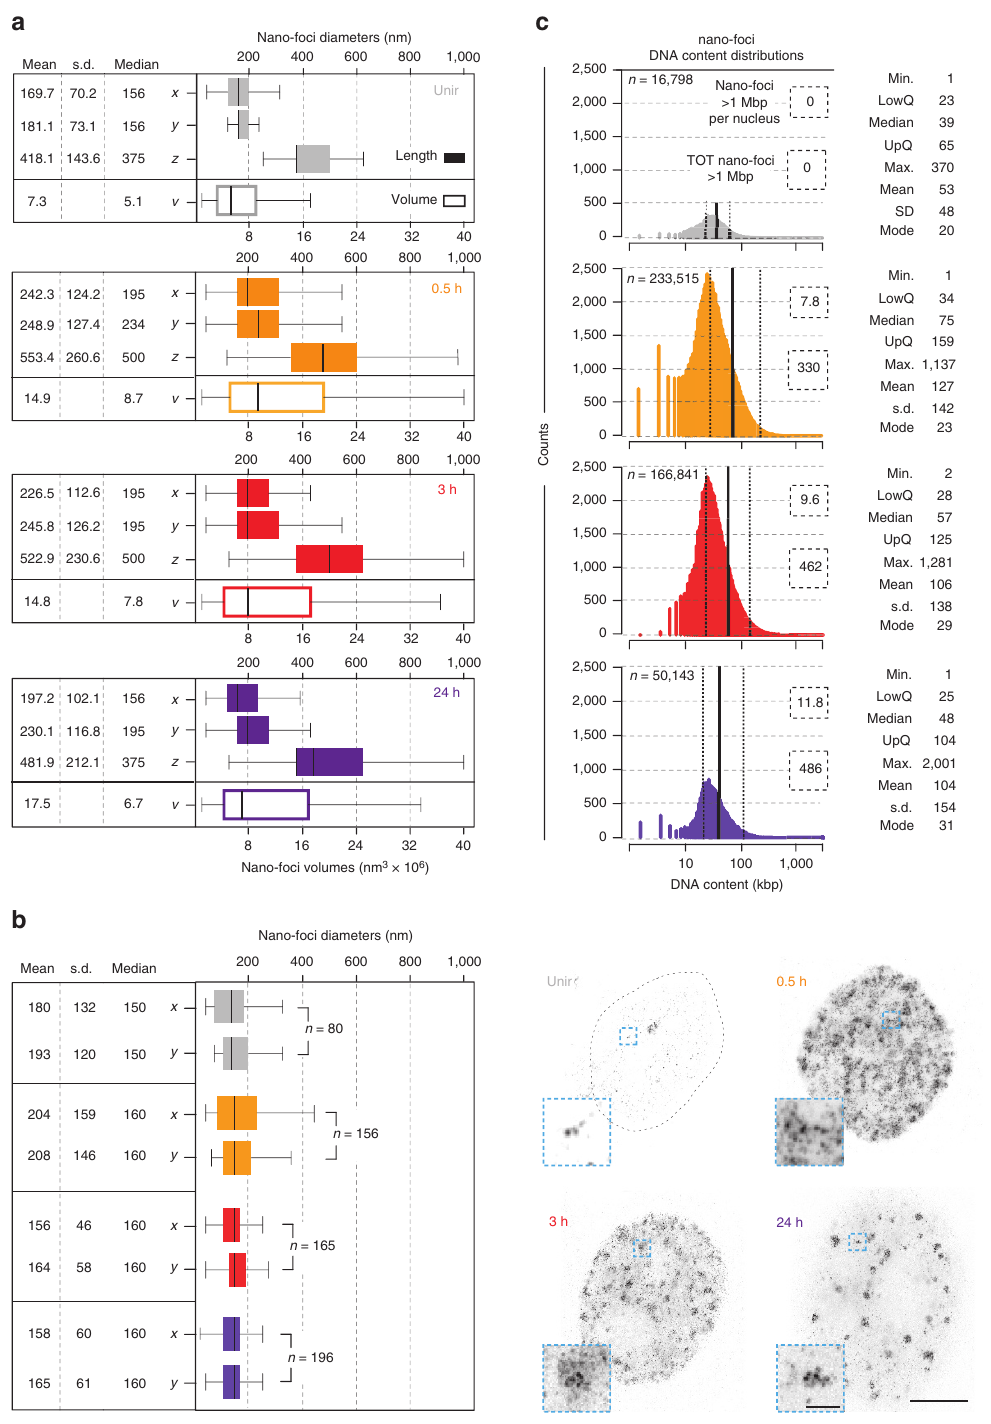
Figure 2 | Metrics of c H2AX nano-foci dimensions and DNA content. ( a ) Quantification of nano-foci diameters in the three dimensions (filled boxes, top) during DDR. From these three dimensions, the volumes were calculated (empty boxes, bottom). The difference between lateral and axial measurements is due to the lower resolution in the axial direction. Figures in nm or nm 3 (cid:3) 10 6 are shown. ( b ) STED microscopy of g H2AX immunofluorescence. (left) Quantification of lateral diameters of g H2AX nano-foci. Statistics and size scale are as in a . (right) Exemplary STED images of cells before and after IR are shown together with the magnified views of the light-blue boxes. Scale bars, 5 m m and 500nm for main micrographs and magnified regions, respectively. ( c ) DNA content distributions of g H2AX nano-foci before and during DDR. Only in IR-exposed cells, we found nano-foci larger than 1 Mbp (dashed boxes), and their frequency never exceeded 1% (0.14%, 0.28%, 0.95% for 0.5h, 3h and 24h, respectively). Kruskal–Wallis w 2 ¼ 18,503, df ¼ 3, P o 2.2 (cid:3) 10 (cid:2) 16 . Statistics (in kb) are shown next to each distribution. All boxes and whiskers are as in Fig. 1. n : total number of measured nano-foci from all imaged cells in two independent experiments, for 3D-SIM ( a , c ) or STED ( b